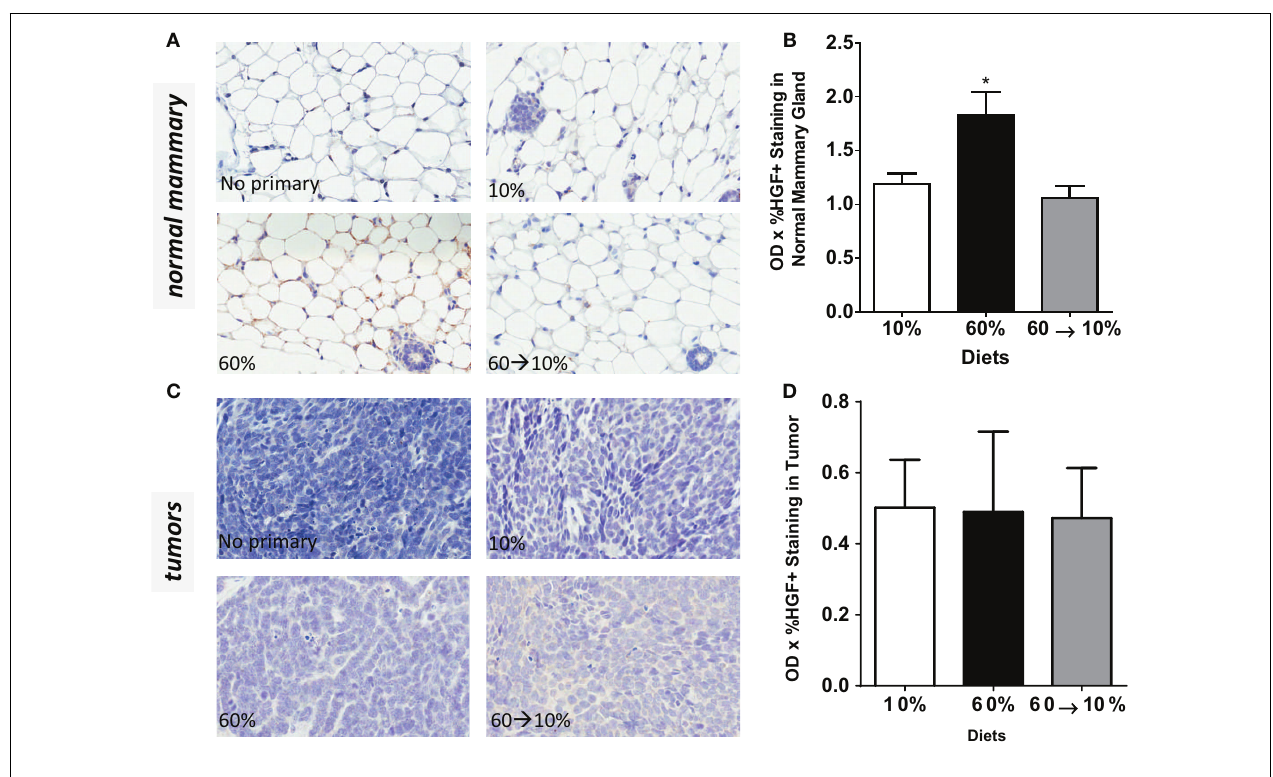
mammary glands and tumors in n = 2 sections from eight mice using Aperio Imagescope software and the color deconvolution algorithm measuring positive pixel counts for diaminobenzidine (DAB) staining. Aperio digital analysis of DAB allows for no subjective bias